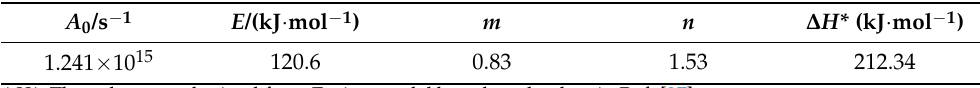
Table 1. Curing kinetic parameters of NEPE propellant.